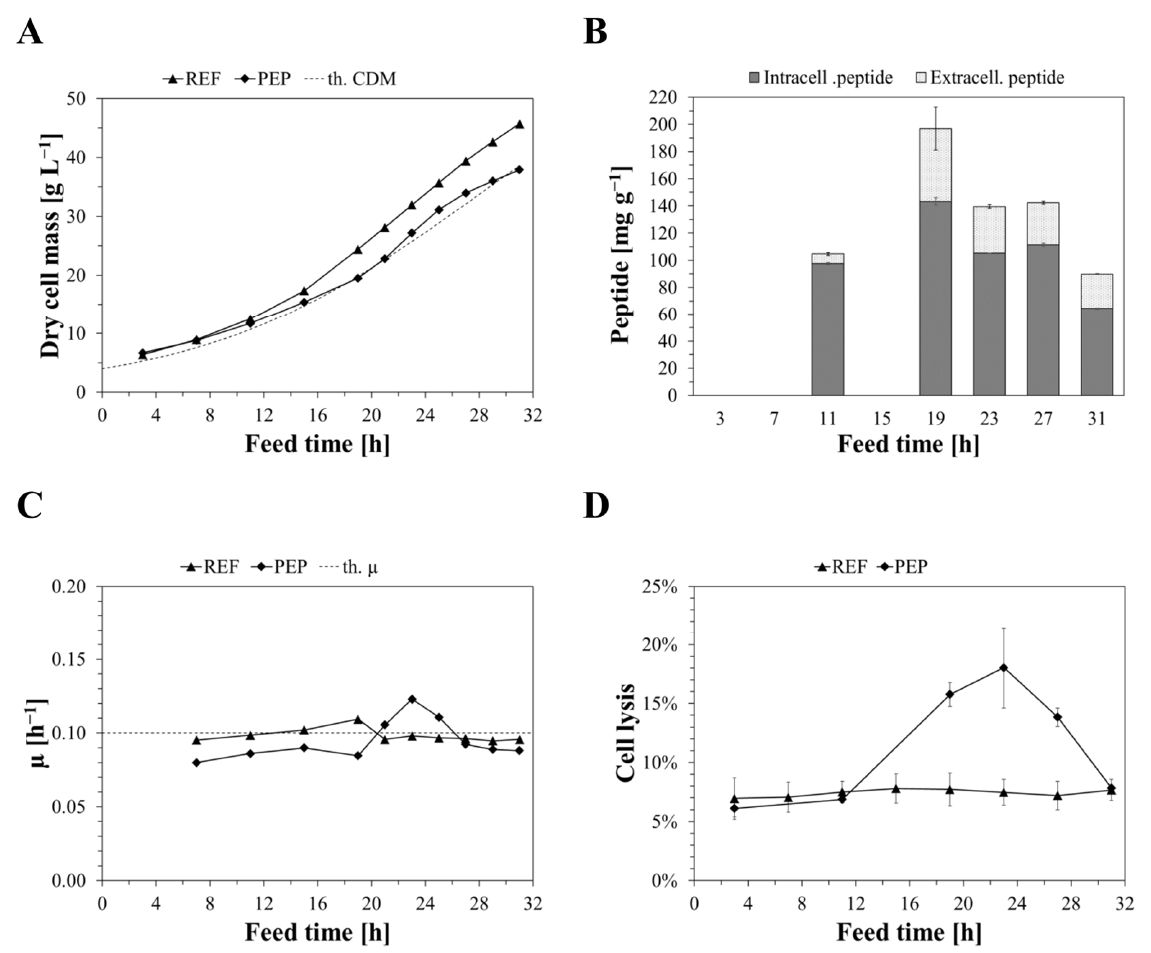
Figure 2. Growth curves of strains of REF and PEP in comparison to the theoretical DCM (th. DCM) ( A ), analysis of intracellular and extracellular peptide content specific to biomass ( B ), actual specific growth rate, μ , of REF and PEP in comparison to the theoretical μ (th. μ ) ( C ), and comparison of percentual cell lysis of REF and PEP ( D ). Scans of SDS-PAGE gels are provided in the Supplementary Materials. Peptide content and estimated cell lysis (DNA) were analysed, at least in technical duplicates. Dry cell mass was estimated in a single determination. Theoretical DCM was calculated according to an exponential feed profile with a theoretical specific growth rate, μ , of 0.1 h − 1 .